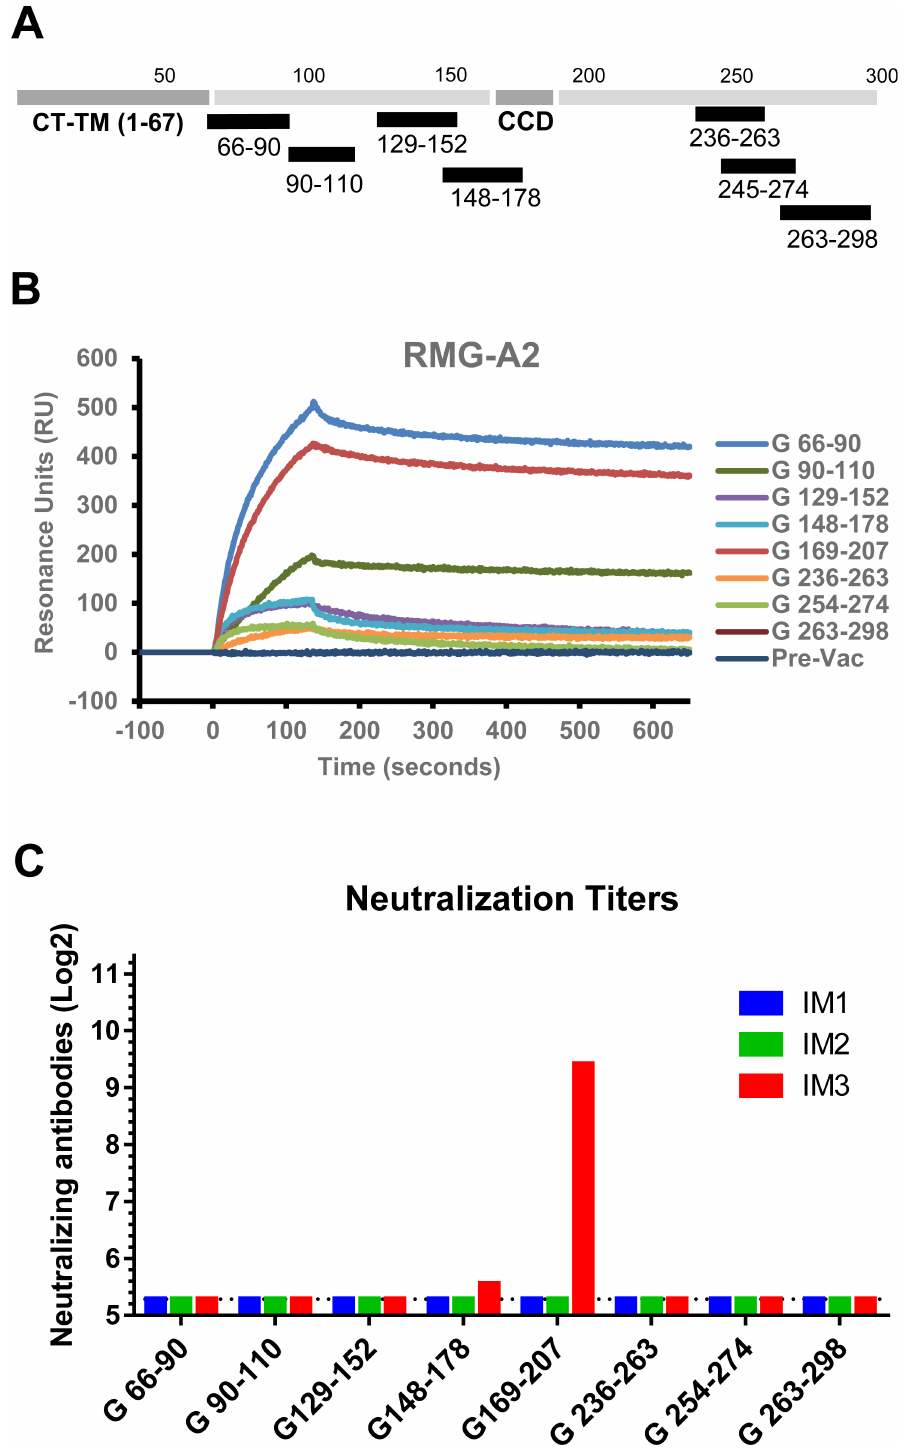
Fig 4. Immunization of rabbits with RSV G peptides. (A) Schematic diagram of RSV G peptides, conjugated to KLH, that were used to immunize rabbits, combined with Emulsigen adjuvant. (B) SPR analysis of post-third vaccination serum antibodies (diluted 10-fold) to RMG from RSV A2 strain. (C) Virus neutralization titers following first, (IM1), second (IM2) and third (IM3) vaccinations. Titer is shown for 50% reduction in number of plaques.